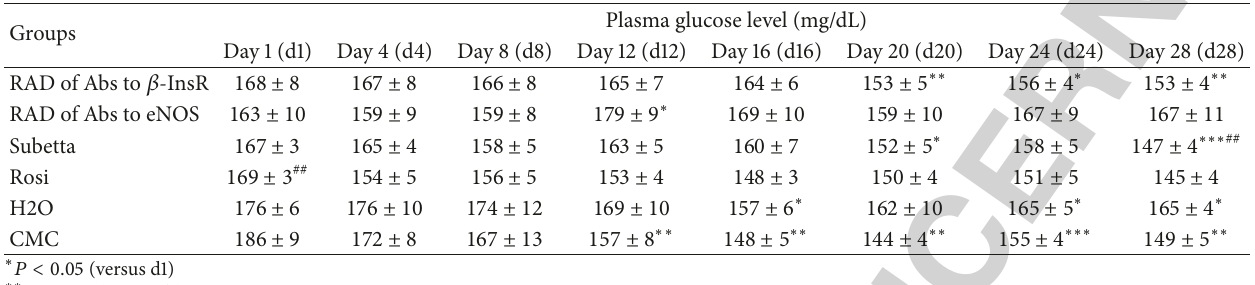
Table 1: Effect of test articles and appropriate controls on Goto Kakizaki/Par male rats basal (non-fed state) plasma glucose level (mg/dL; M ± SEM) during treatment period (28 days) ( 𝑛 = 12 in each group). Groups